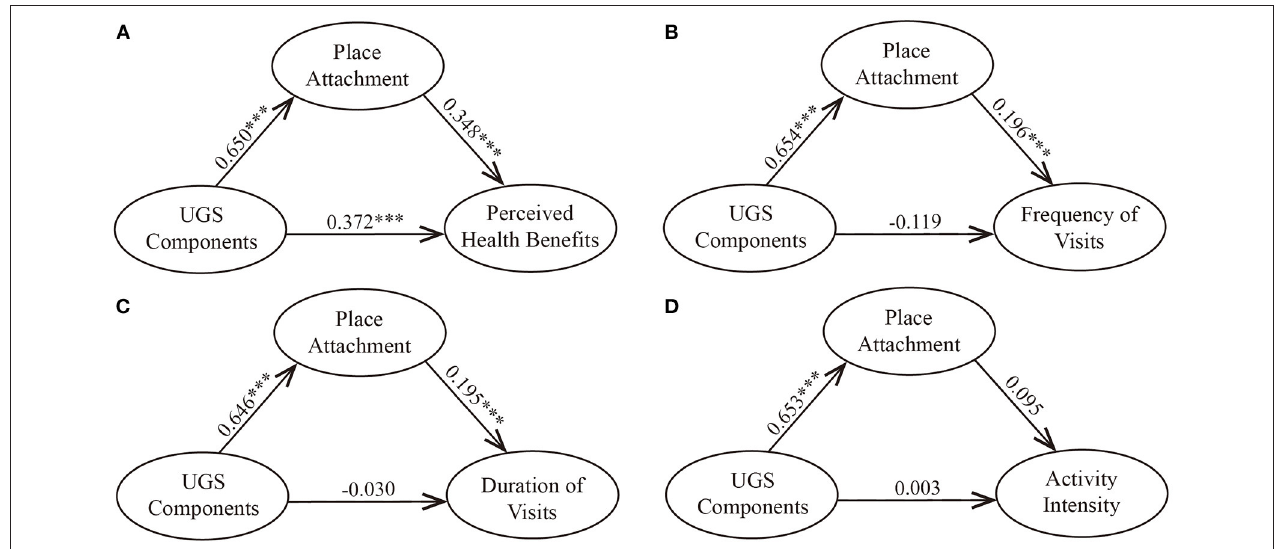
FIGURE 4 | Mediation paths. (A) Model 7. (B) Model 8. (C) Model 9. (D) Model 10. *** p <